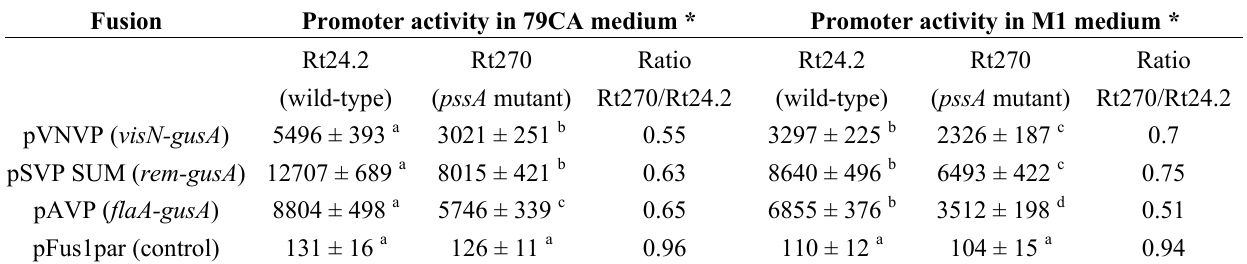
Table 2. The expression of visN-gusA , rem-gusA , and flaA-gusA fusions in the Rhizobium leguminosarum bv . trifolii wild-type and the pssA mutant backgrounds. Fusion Promoter activity in 79CA medium